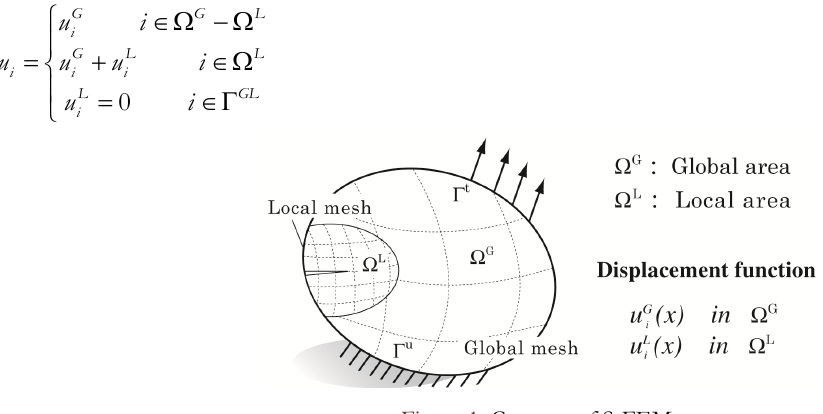
Figure 1: Concept of